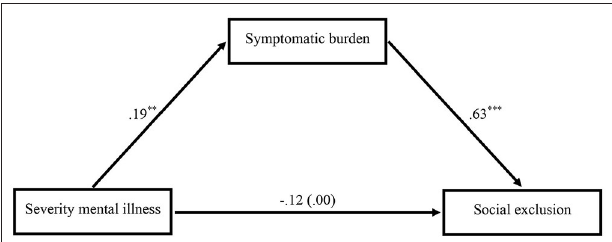
FIGURE 1 | Mediation model showing the impact of the severity of the mental illness on social exclusion via the symptomatic burden ( n = 82). The total effect of the severity of the mental illness on social exclusion without controlling for the symptomatic burden is shown in parentheses. Unstandardized regression coefficients. Two-sided testing of significance. ** p < 0. 01, *** p < 0.001.